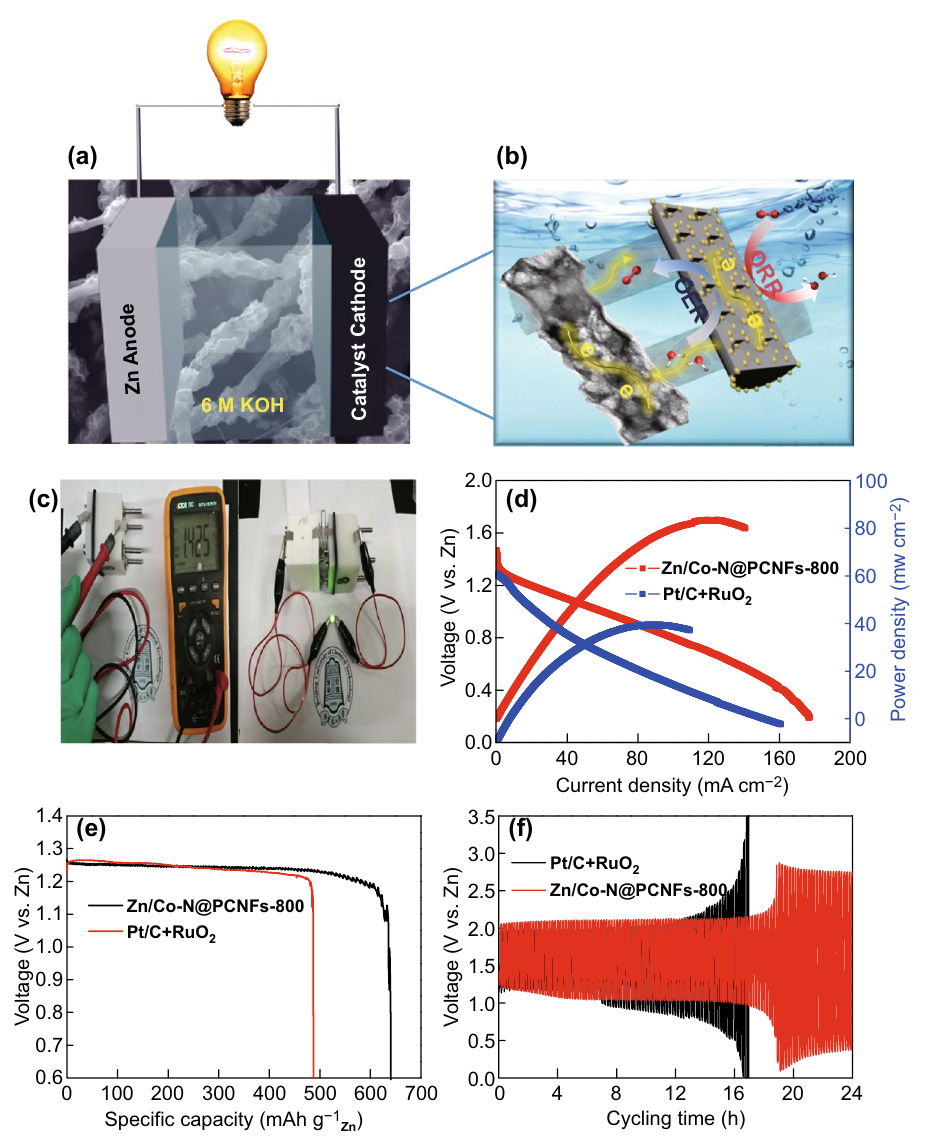
Fig. 9 a Schematic representation of the basic configuration of a two electrode Zn–air battery by coupling the Zn electrode with an air electrode to execute ORR and OER in 6 M KOH solution as the electrolyte. b Catalytic mechanism diagram of cathode about Zn/Co–N@PCNFs-800. c Photographs of a green LED (1.8 V) powered by two Zn–air batteries integrated in series. d Discharge polarization and power density curves of the Zn–air batteries using Zn/Co–N@PCNFs-800 and 20 wt% Pt/C + RuO 2 as ORR catalysts (mass loading of 1.2 mg cm −2 ). e Specific capaci- ties for the Zn–air battery using Zn/Co–N@PCNFs-800 and 20 wt% Pt/C + RuO 2 as an ORR catalyst, which was regularized with consumed Zn mass. f Galvanostatic discharge and charge cycling curves at 10 mA cm −2 with each cycle for 10 min (5 min charge and 5 min discharge) of rechargeable Zn–air batteries with the Zn/Co–N@PCNFs-800 and 20 wt% Pt/C + RuO 2 as the cathode